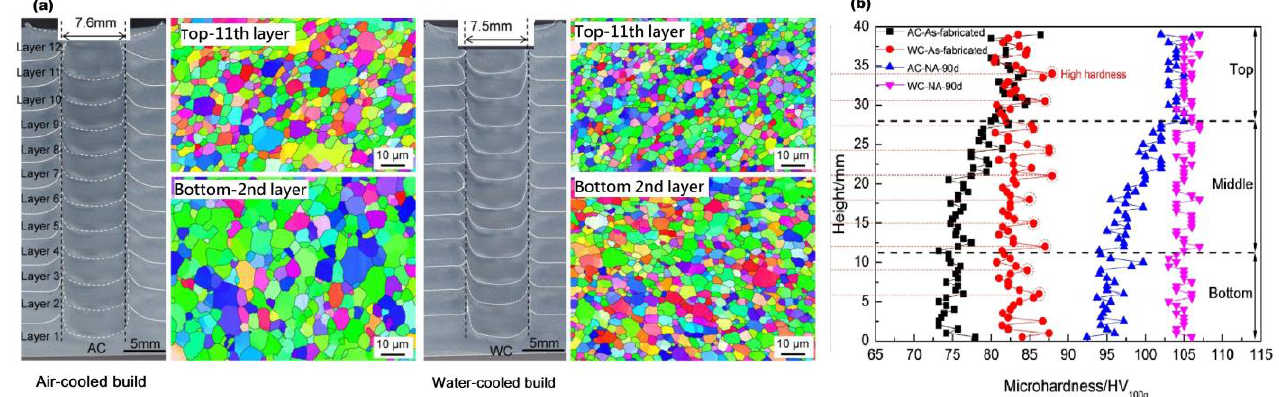
Figure 13. Natural aging and under water fabrication effect on microstructure and hardness of identical material laminates: ( a ) Microstructure comparison; ( b ) microhardness comparison (reprinted from [85] with permission from Elsevier).